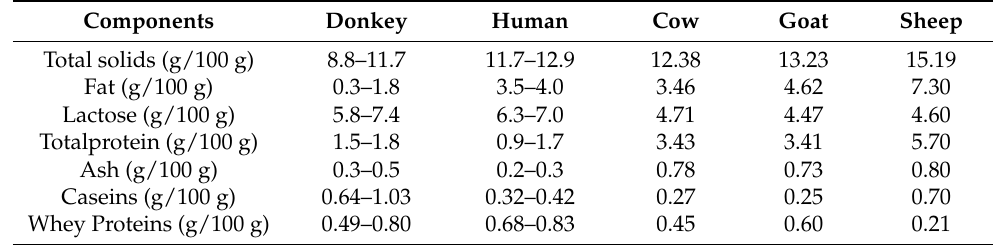
Table 3. Nutritional compositions of milk from donkeys and other species. Components Donkey Human Cow Goat Sheep Total solids (g/100